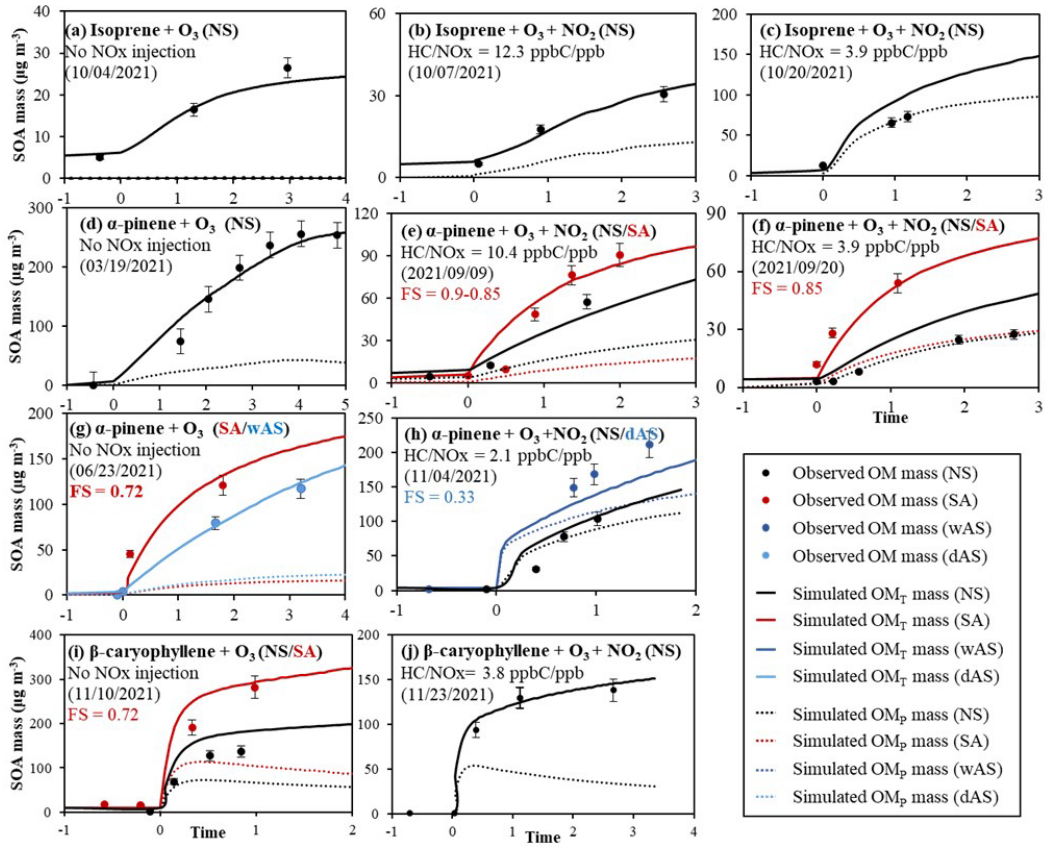
Figure 2. Observed (symbols) and simulated SOA mass (line) for the ozonolysis of isoprene (a–c) , α -pinene (d–h) , and β -caryophyllene (i, j) under different seed conditions and NO x levels. SOA mass concentrations are corrected for the particle loss to the chamber wall. The simulated OM T (solid line) and OM P (dotted line) are also illustrated. The error (10%) associated with SOA mass was estimated with the instrumental uncertainty. NS, SA, wAS, and dAS indicate non-seeded, sulfuric-acid-seeded, wet-ammonium-sulfate-seeded, and dry- ammonium-sulfate-seeded experiments, respectively.